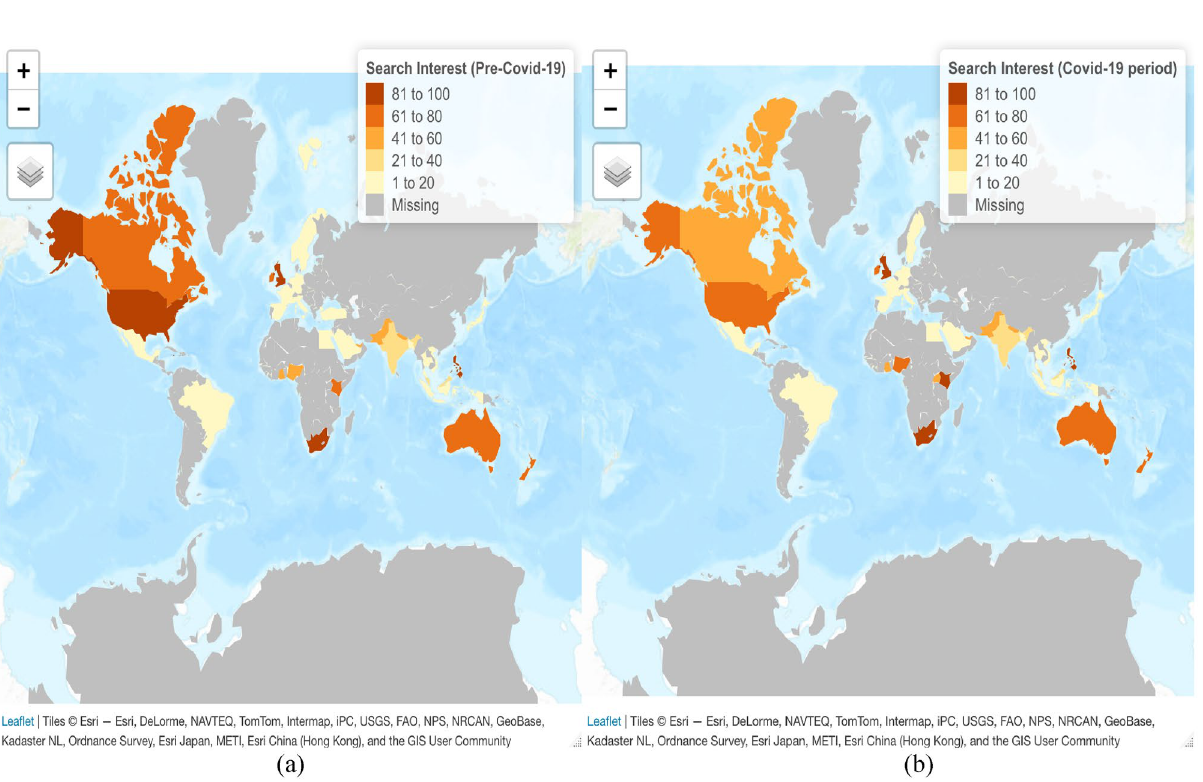
Figure 3. Web search interest (Google Trends) for term “headache” at country level: Pre-pandemic period (February 2017–January 2020) ( A ); pandemic period (February 2020–Febraury 2022) ( B ). Source: Authors’ representation, created with the “tmap” package (https:// cran.r- proje ct. org/ web/ packa ges/ tmap/ vigne ttes/ tmap- getst arted. html) in RStudio